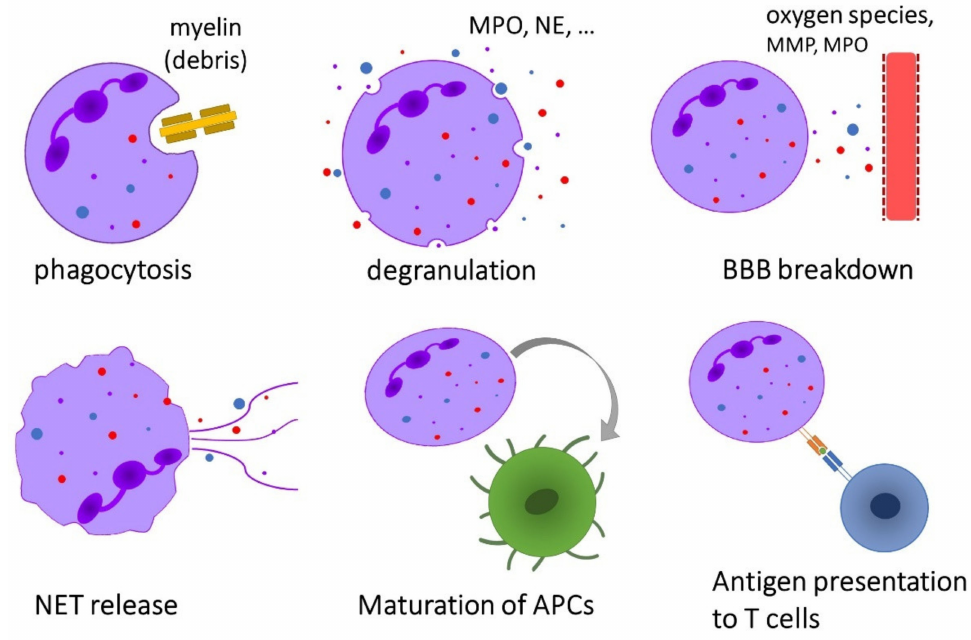
Figure 2. Overview of the e ff ector functions of neutrophils that are possibly implicated in the pathogenesis of multiple